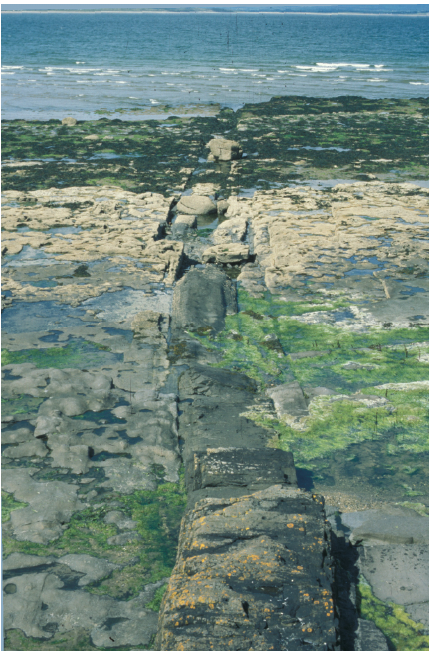
Figure 14. Inishcrone, County Sligo: Palaeogene dyke in Carboniferous Limestone.